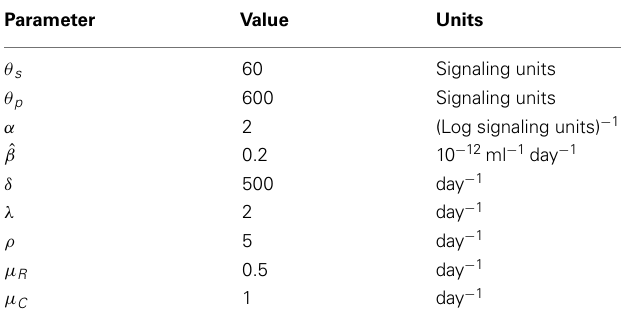
Table 1 | Parameter choices for the mathematical model